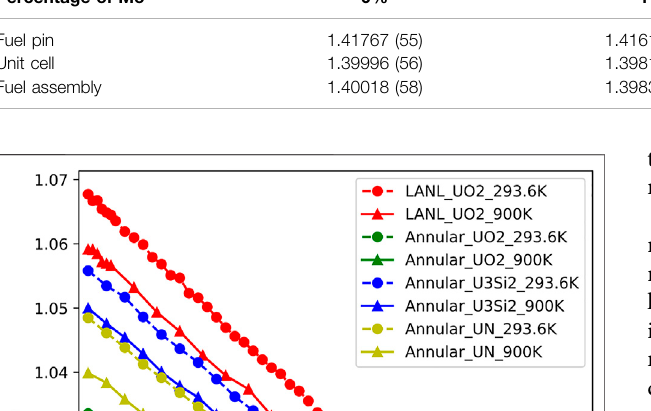
TABLE 6 | The effect of Mo in SS316 on k eff for the three simple models under 293.6 K. Percentage of Mo